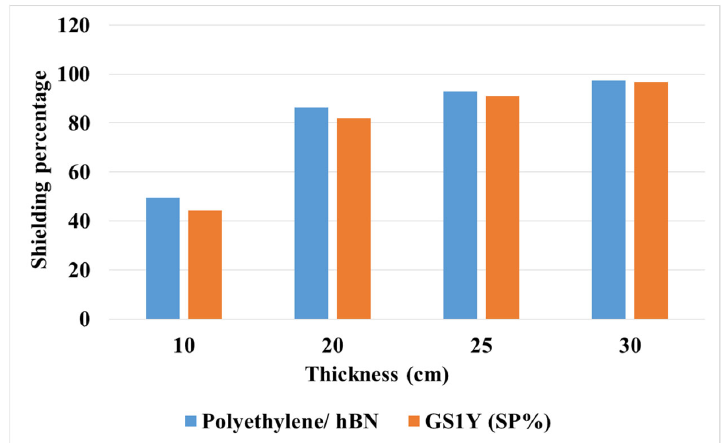
Figure 9. Shielding percentage obtained from polyethylene/h ‐ BN and GS1Y.